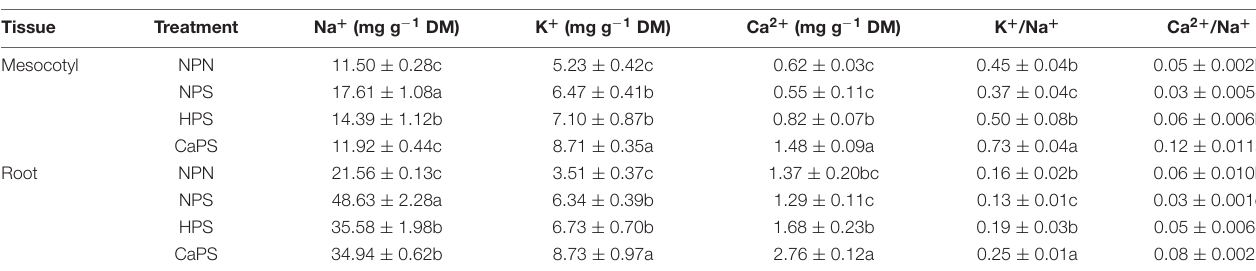
FIGURE 3 | Effect of CaCl 2 priming on osmotic adjustment substances in sorghum tissue under salt stress. TSS, total soluble sugar; FAA, free amino acid; SP, soluble protein. TABLE 3 | Effect of CaCl 2 priming on ion content in sorghum tissue under salt